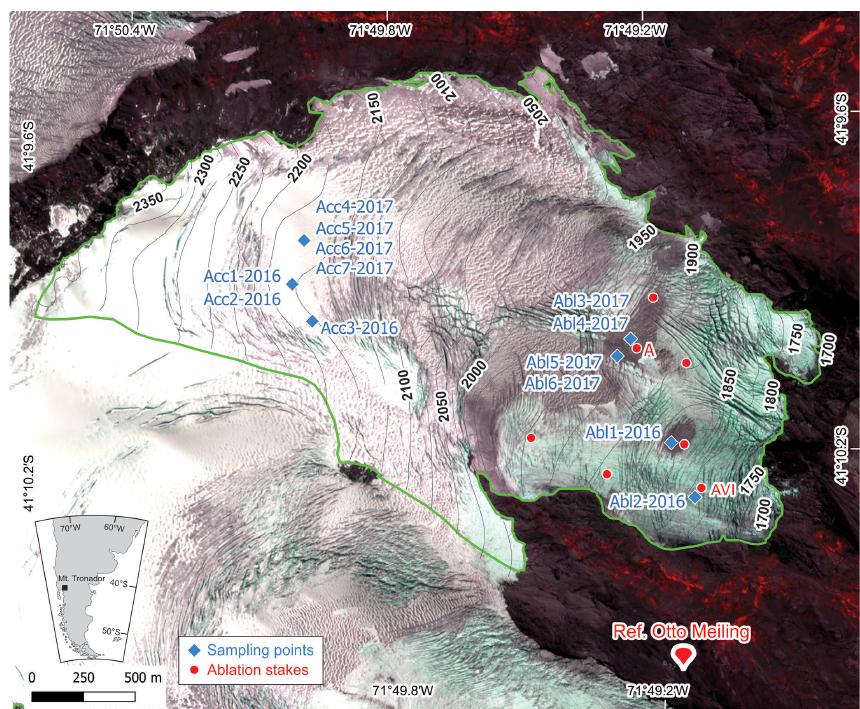
Figure 1. Outline of Alerce Glacier, showing the location of sampling sites and ablation stakes used for mass balance model calibration (model output for labeled ablation stakes is shown in Fig. S6). Labels of contour lines of terrain elevation are expressed in meters above sea level. Otto Meiling mountain hut and inset of the location of Mount Tronador in the context of southern South America are represented for reference. Background image: false-color pansharpened Pléiades satellite image, 7 March 2012, PGO, CNES Airbus DS (Ruiz et al.,